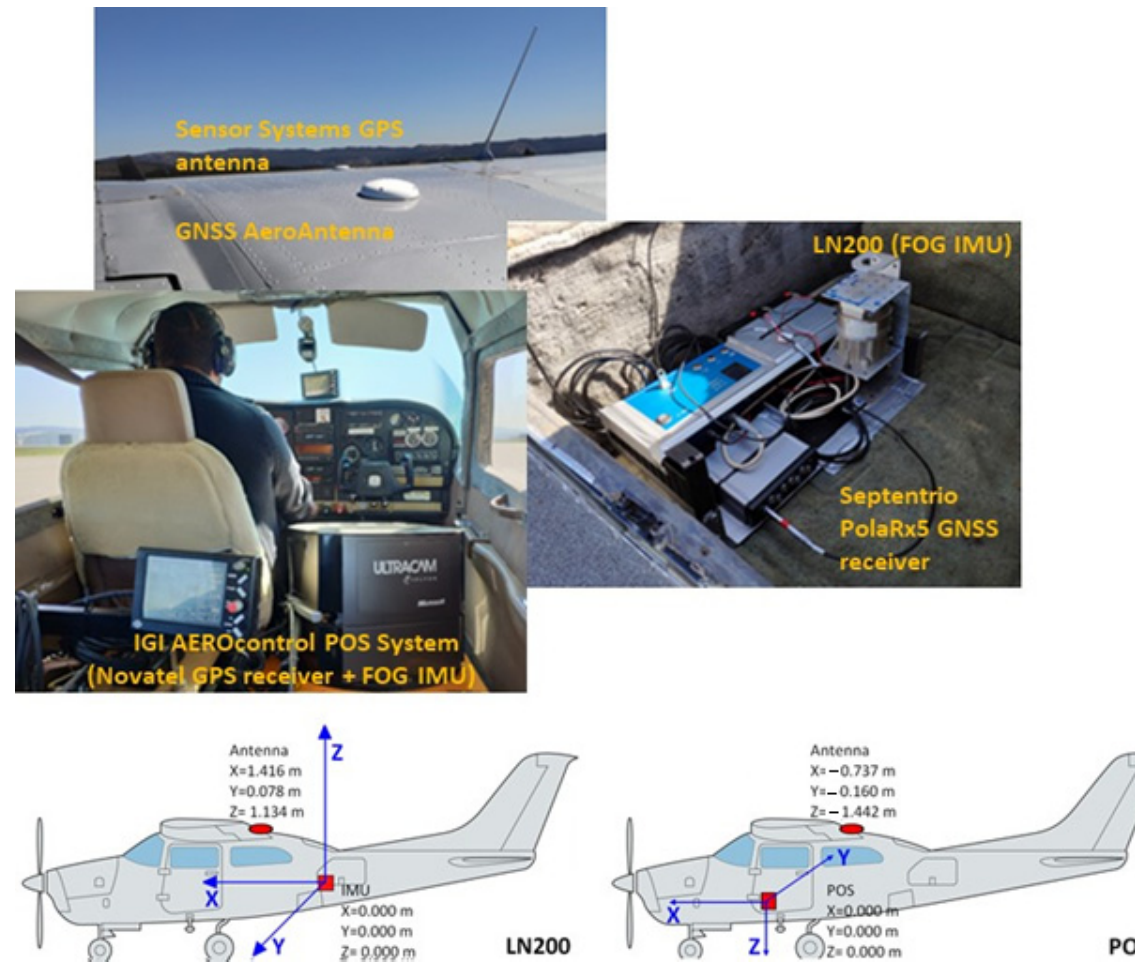
Figure 2. Aircraft trajectories of the four aerial campaigns.